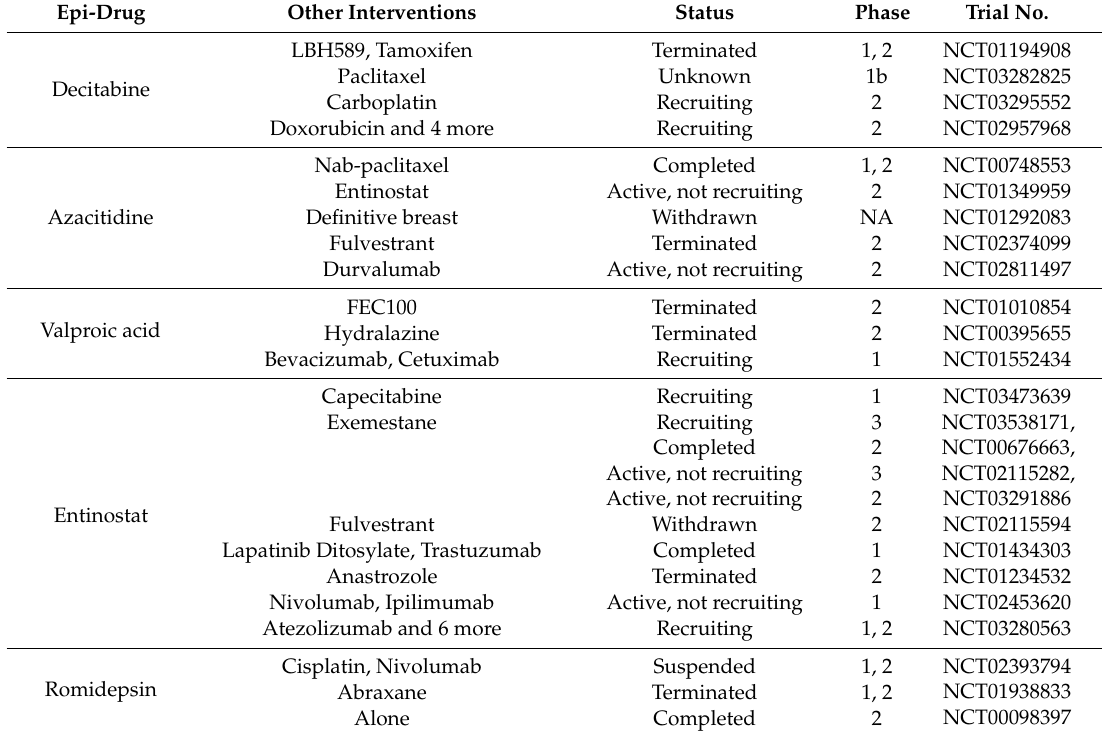
Table 1. Epigenetic drugs in clinical trials focused on breast